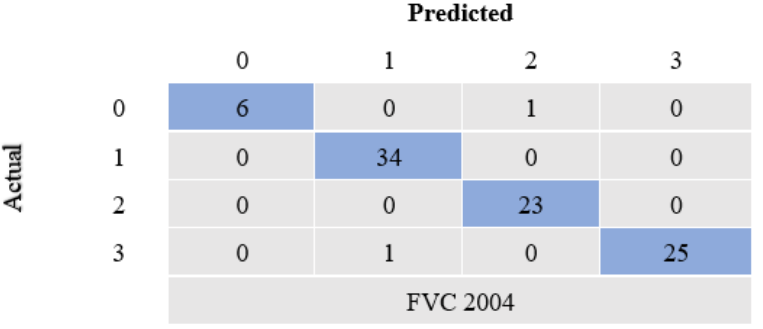
Figure 7. Confusion matrix based on FKTNET-5 model for FVC2004 dataset.